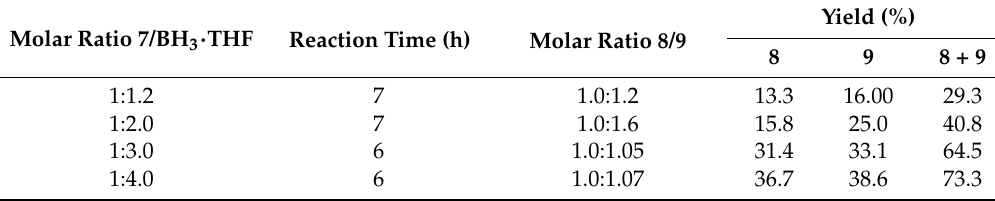
Table 1. Hydroboration of the alkene-diol 7 with